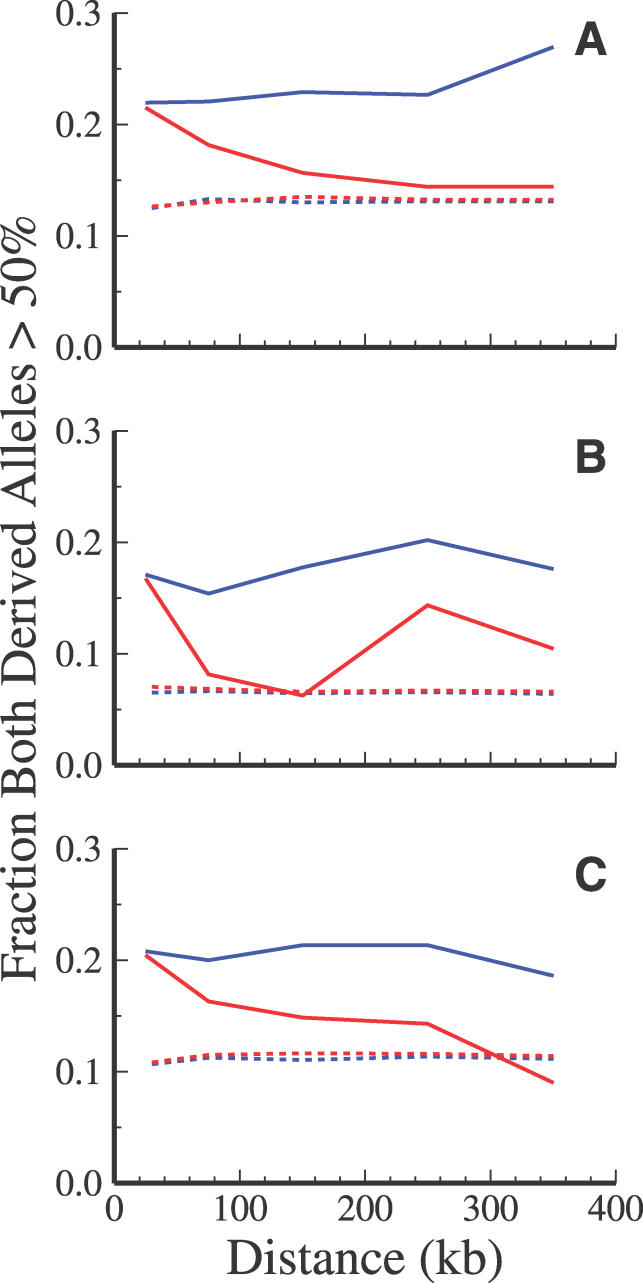
Fraction of SNP Pairs where Both Derived Alleles Occur at Higher Frequencies than the Ancestral AlleleFraction of SNP pairs where both derived alleles occur at higher frequencies than the ancestral allele for European (A), African-American (B), and Chinese (C) populations. Red lines are for intergenic regions and blue lines are for genic regions; solid lines are for perfectly correlated SNP pairs and dashed lines are for SNP pairs with r
2 < 1.